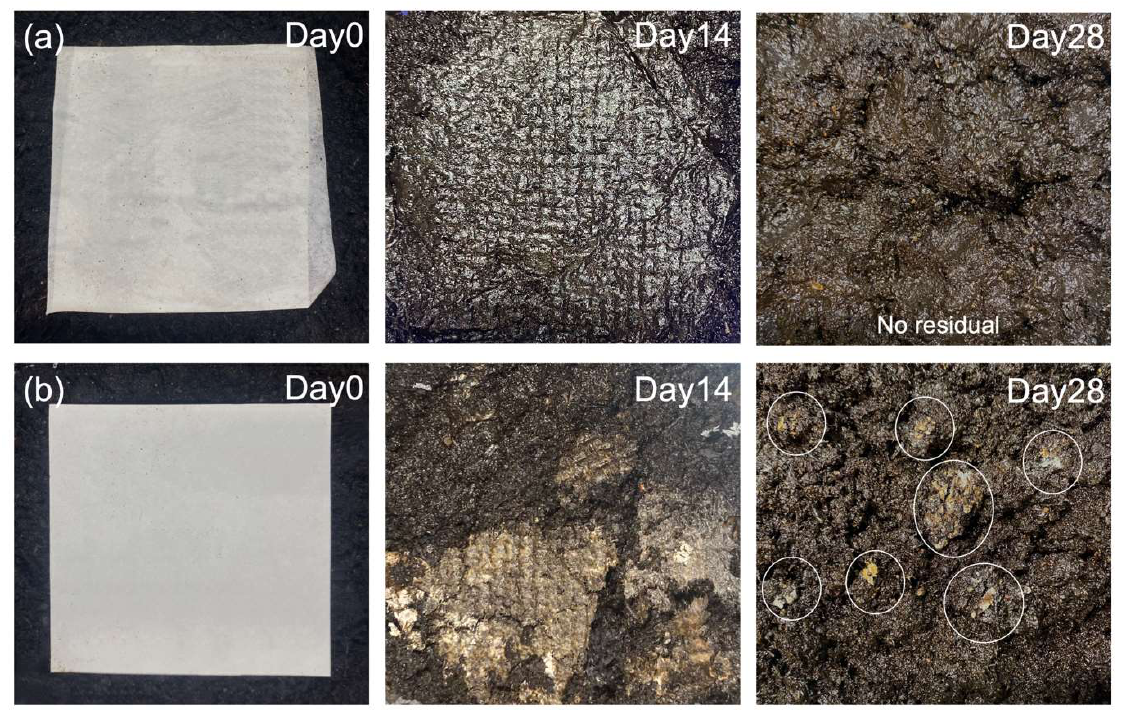
Figure 7. Biodegradability of the developed composite zein filter: ( a ) zein filter degradation within 28 days; ( b ) cellulose filter paper degradation within 28 days.